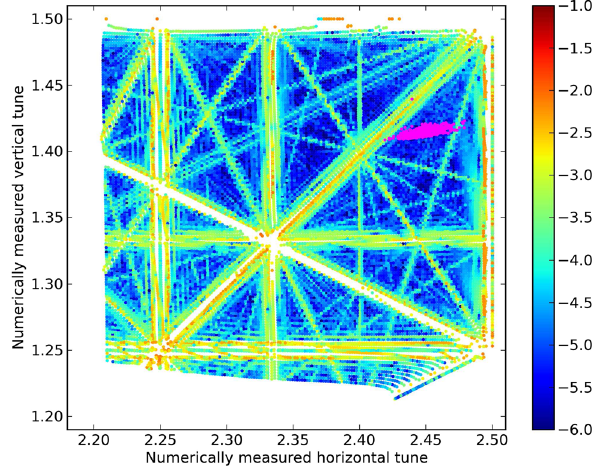
FIG. 7. D plotted as colors against the numerically measured tunes for the ELENA machine with electron cooler. The magenta dots in this plot correspond to the tunes of particles which survived 10 4 turns in a bunch filling the acceptance, without space charge included in the